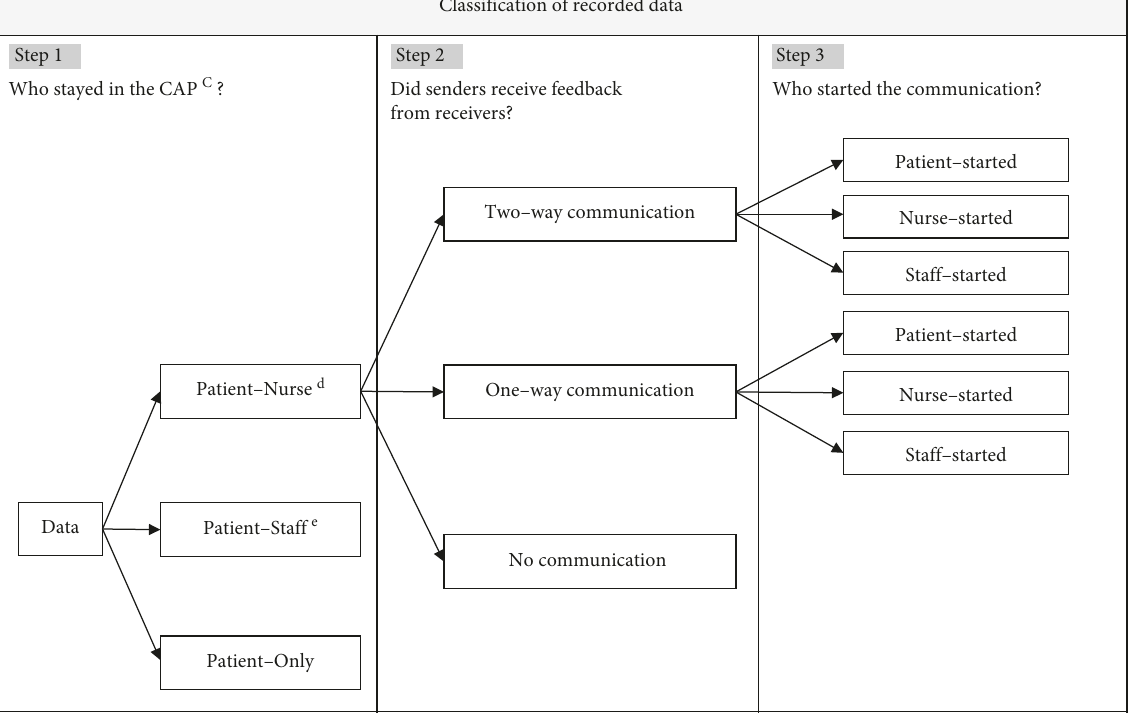
Figure 2: Flow diagram for classification of recorded data. (c) CAP: Conversation Area of the Patient. A space approximately 150cm to the left and right from the center of the bed on which a patient is lying and approximately 50 cm above the headboard. (d) The nurse in Patient- Nurse refers to nurses assigned to the patients who participated in the study. Some Patient-Nurse scenes included additional healthcare professionals such as medical doctors, physiotherapists, medical engineers, or nurses who provided care in conjunction with the assigned nurses. (e) The staff in Patient-Staff refers to healthcare professionals and does not include nurses assigned to the patients who participated in the study.